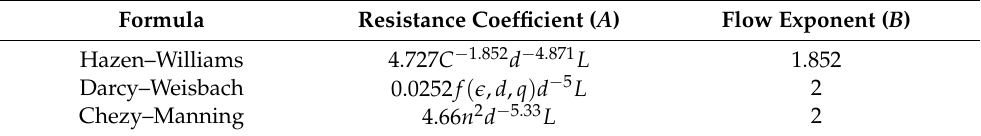
Table 1. Resistance coefficient and flow exponent values for each head loss formula in